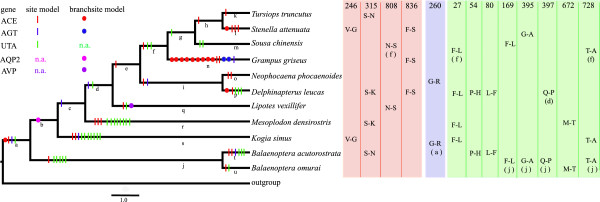
Radical amino acid changes in selected sites across the cetacean phylogeny. Parallel amino acid substitutions occurred in three selected genes (ACE, AGT, and SLC14A2) shown on the right of the figure. The selected genes and their corresponding parallel amino acid substitutions in cetaceans are marked with different colors, i.e., ACE (red), AGT (blue), SLC14A2 (green), and AQP2 (purple). Selected sites identified using site models and branch-site models are indicated separately by vertical lines and circles, respectively. For each amino acid position, the parallel amino acid is labeled on the right of the corresponding terminal branches, while a, d, and f in parentheses indicate the internal branches where the parallel changes occurred. Terrestrial mammals were used as outgroups including cetartiodactyls, carnivores, rodents, and primates.